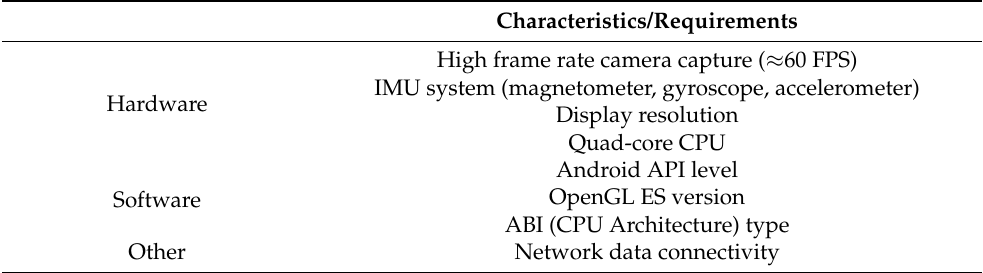
Table 1. Minimum technical specifications and requirements of the modern MAR